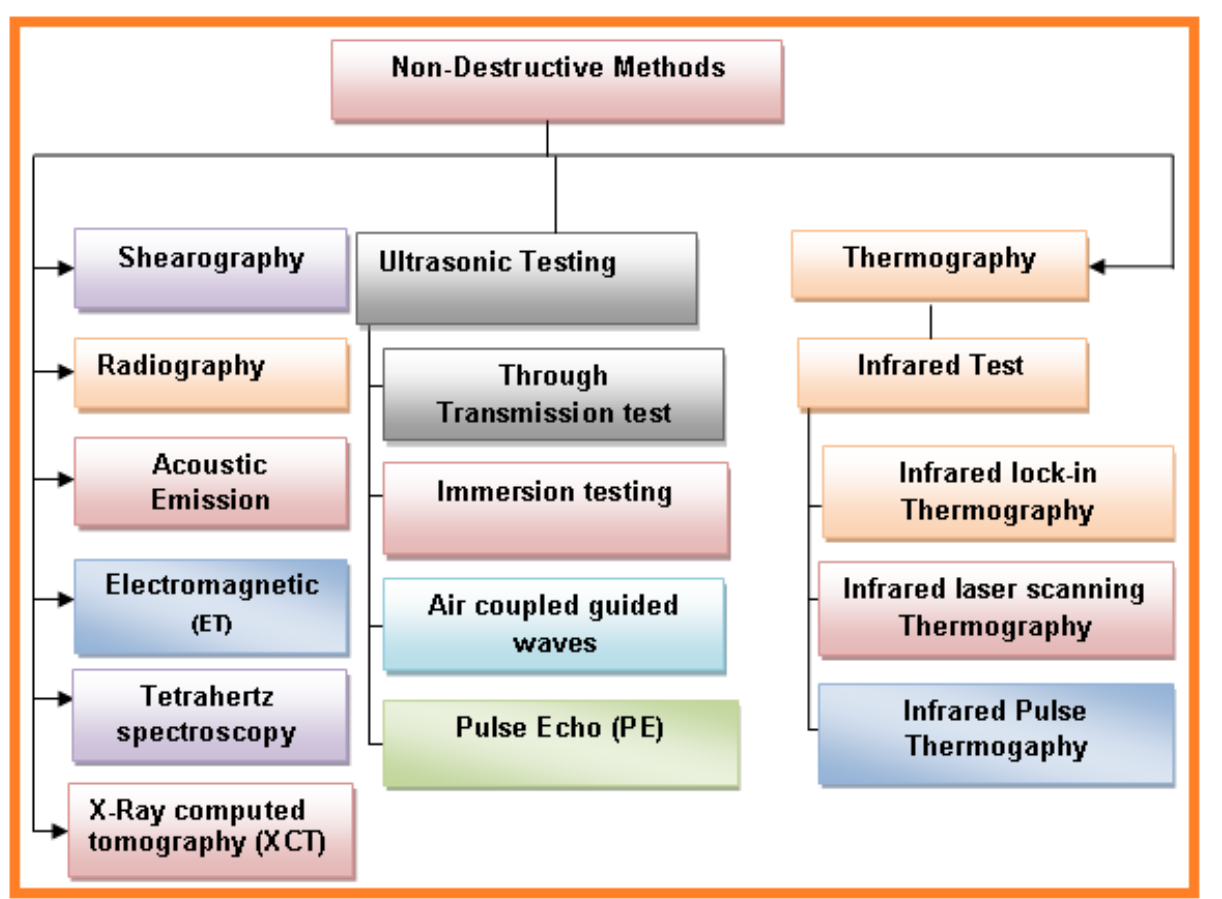
Figure 4. Most common advanced nondestructive diagnostic tests used for engineered materials.